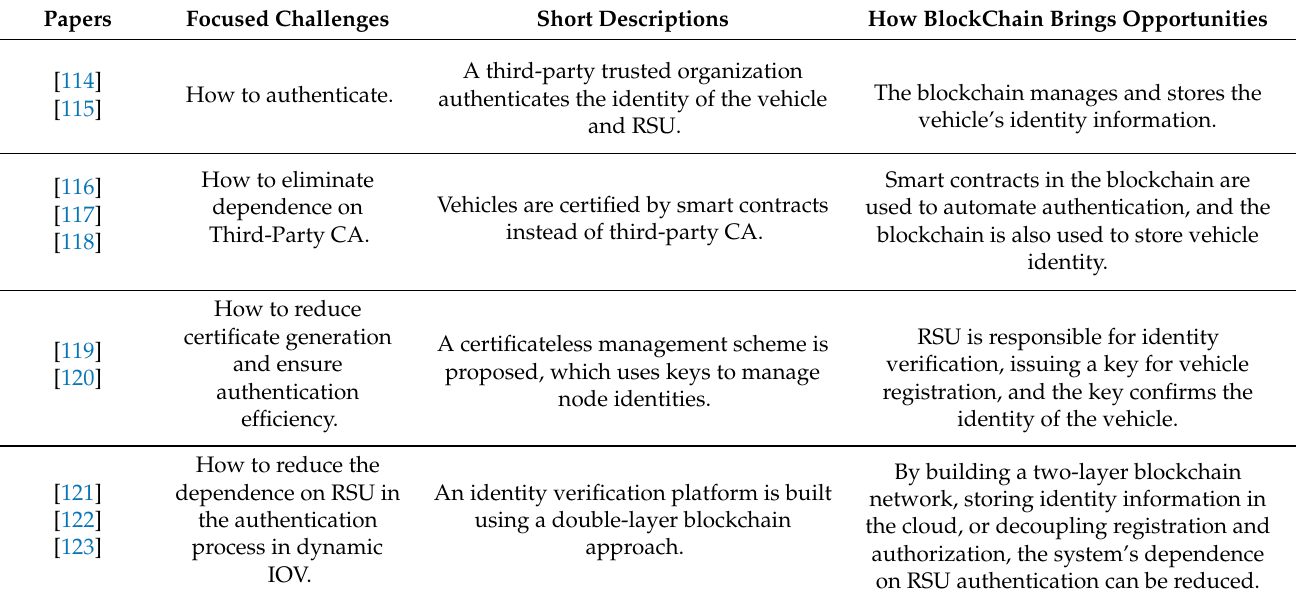
Table 5. Identity Management Related